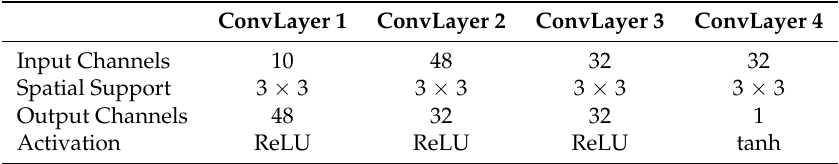
Table 3. Hyper-parameters of the convolutional layers for the proposed CNN